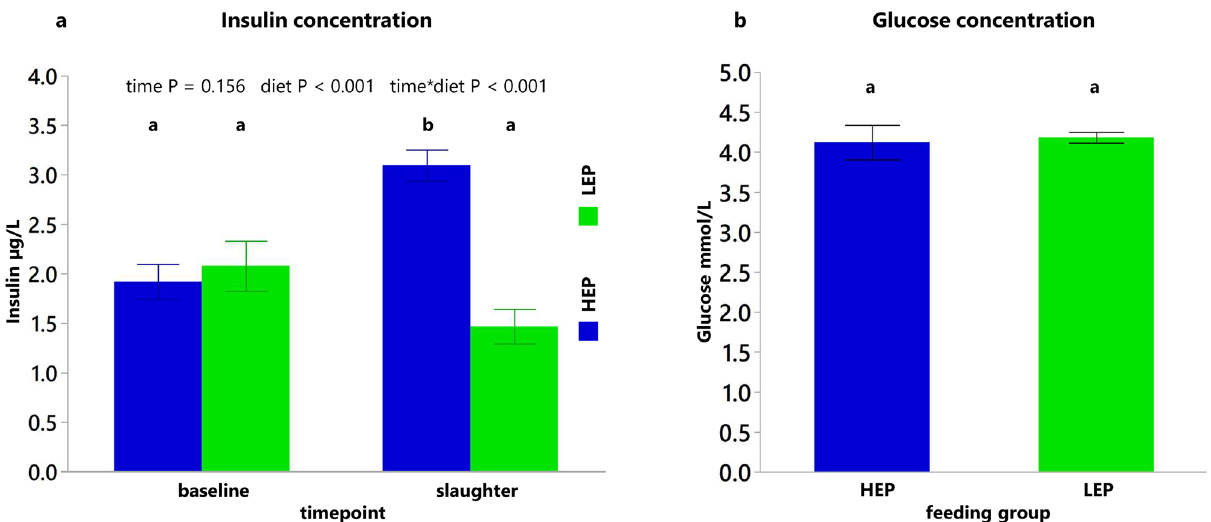
Figure 4. Insulin and glucose profile. ( a ) Insulin concentration in serum at baseline and slaughter. ( b ) Glucose concentration in plasma at slaughter. Data shown as means ± SEM, n = 15, different letters indicate significant difference (P < 0.05). HEP = group fed high energy and protein diet, LEP = group fed low energy and protein